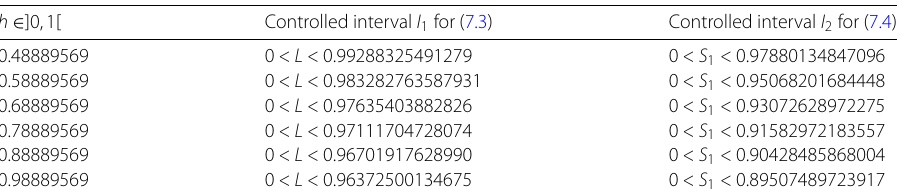
Table 1 Comparison of the modified hybrid method (5.2) and hybrid method [52] for L , S 1 ∈ ]0,1[ and a = 2.0099, q 1 = 0.0189, q 2 = 1.2994, r = 10.5923, E = 0.9959, k = 1.3997, β = 98.499, α = 2.9999, δ = 0.0384, ρ = 10.5842, m 1 = 0.6222, m 2 = 0.4422, h ∈ (0,1) h ∈ ]0,1[ Controlled interval I 1 for (7.3) Controlled interval I 2 for (7.4)